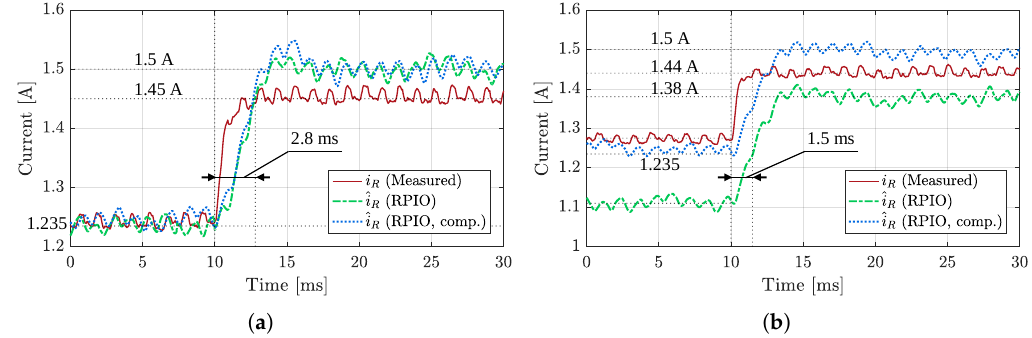
Figure 12. Experimental current response. ( a ) current responses when V 2 = 25 V; ( b ) current responses when V 2 = 20